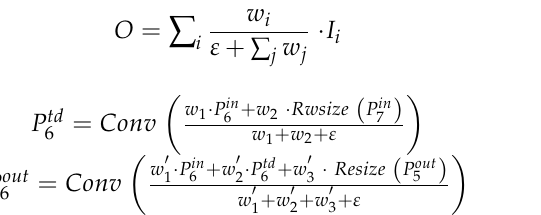
Figure 4. Feature extraction diagram of four types of pavement defects by BiFPN and PANet network structures. ( a ) lateral cracking, ( b ) longitudinal cracking, ( c ) alligator cracking, and ( d ) pothole.